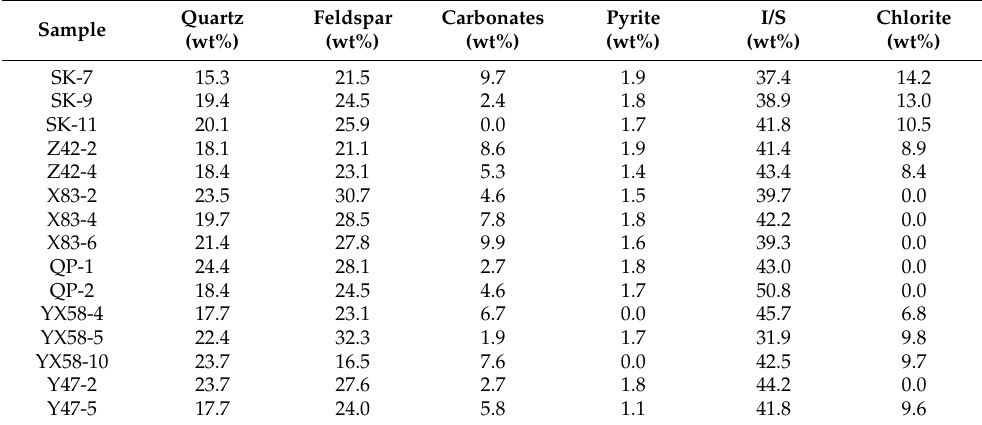
Table 2. Mineral compositions of the Qingshankou Formation shales in Songliao